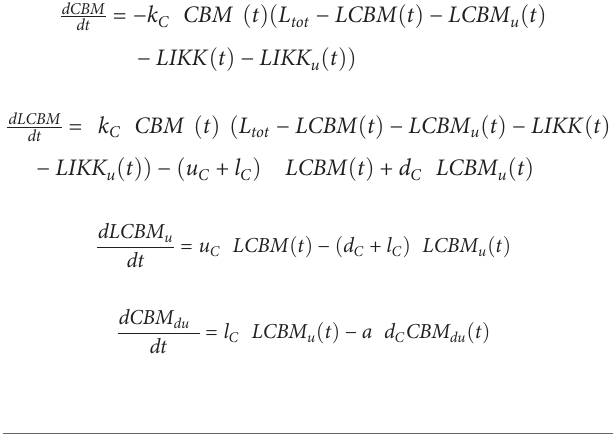
TABLE 1 | Parameters for CBM_SM.